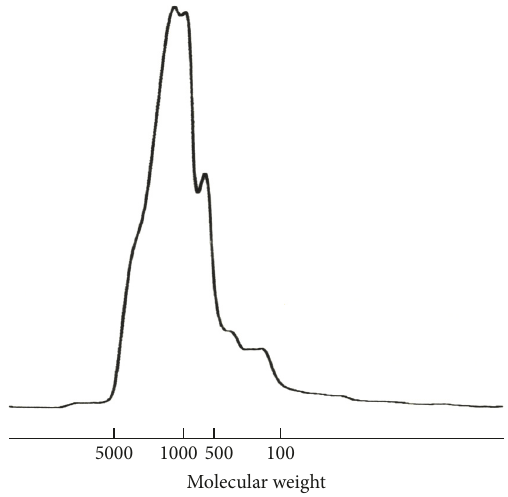
Figure 4: GPC chromatogram of the methylated methanol fraction of tea mangrove extract.